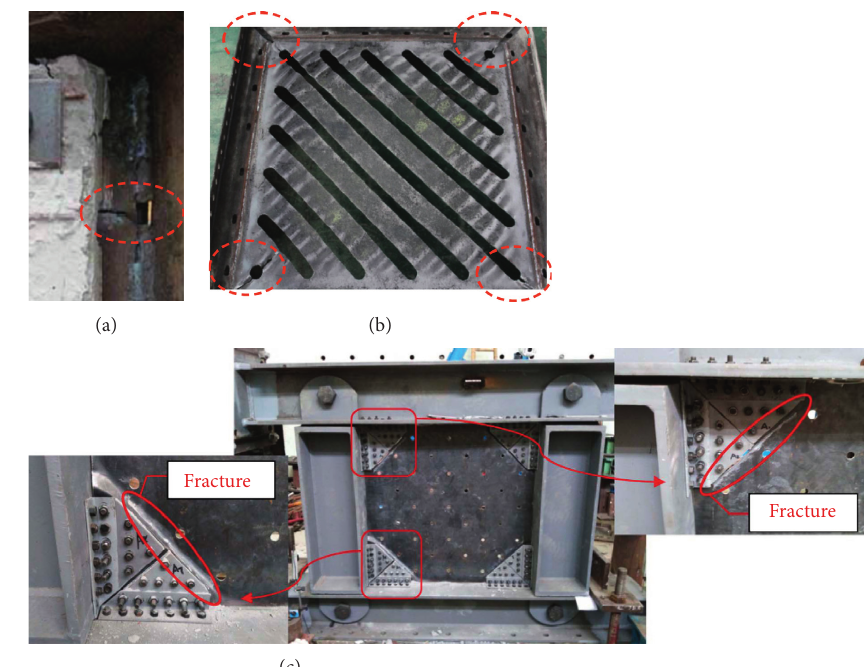
Figure 1: Infilled steel plate torn off at corners. (a) Result of CSPSW (Guo et al. [26]). (b) Result of test specimen (Jin et al. [34]). (c) Result of P-SWSW1 (Wei et al. [33]).